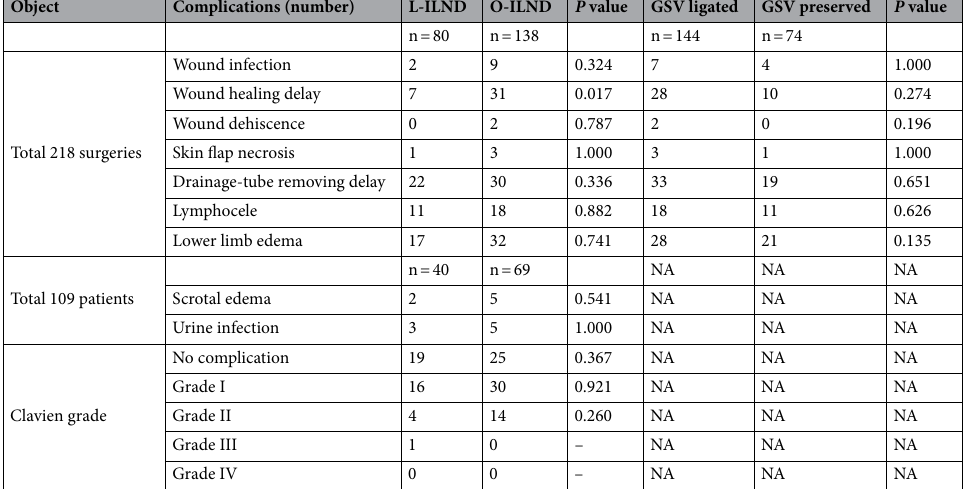
Table 3. Complications reported in the minimally invasive and open groups of patients. L‑ILND laparoscopic inguinal lymph node dissection, O‑ILND open inguinal lymph node dissection, n number.